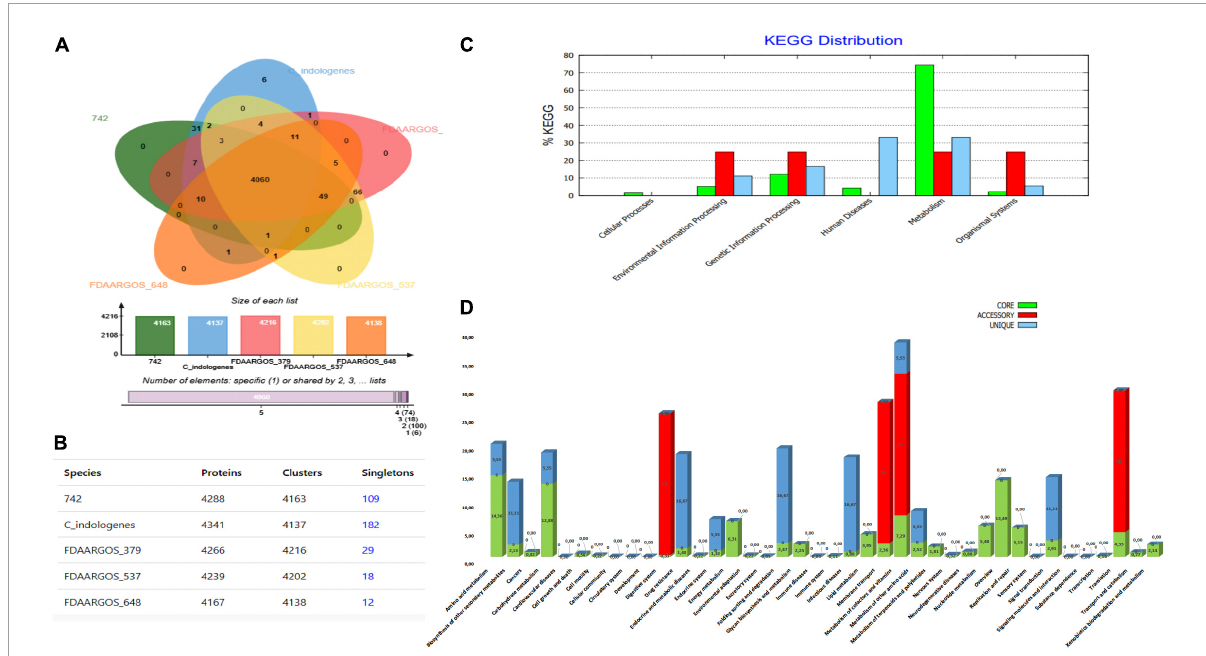
FIGURE5 Comparative genomic analysis. (A ) Venn diagram and bar chart showing the numbers of unique and shared orthologous genes in the five most closely related C. indologenes . (B) Number of proteins, clusters, and singletons. ( C ) KEGG pathway classification in core, accessory, and unique genomes. (D) Distribution of KEGG pathway